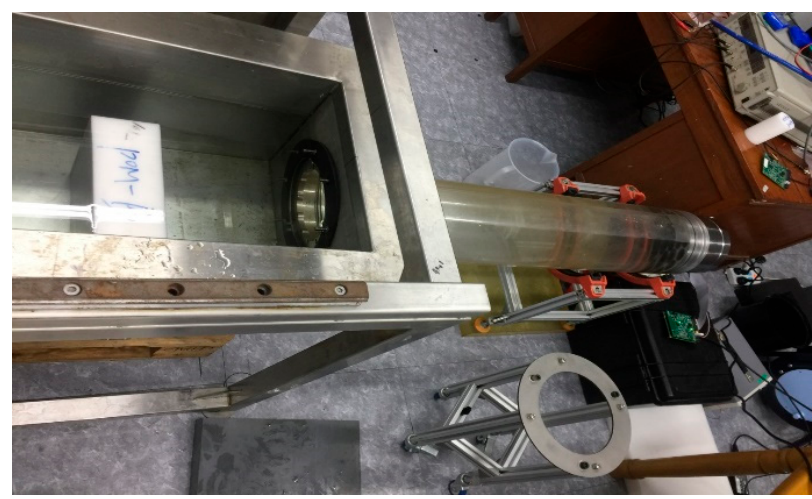
Figure 4. The configuration of the laboratory measurement with the phantom.